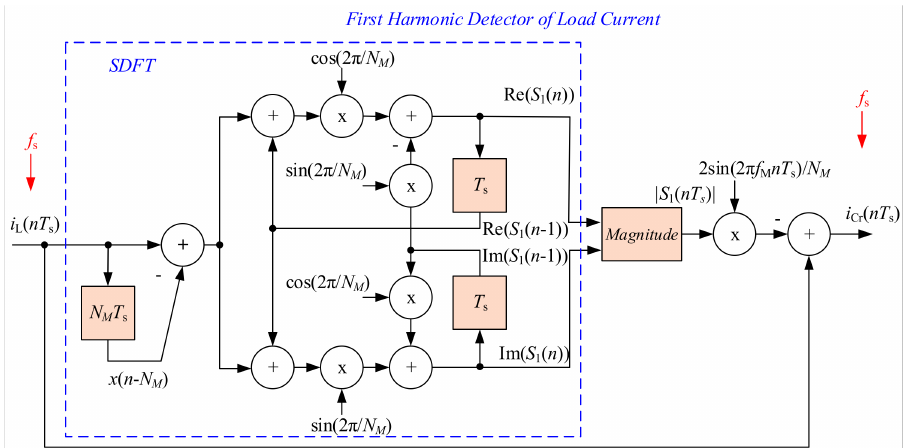
Figure 7. Block diagram of circuit for calculating compensation current.